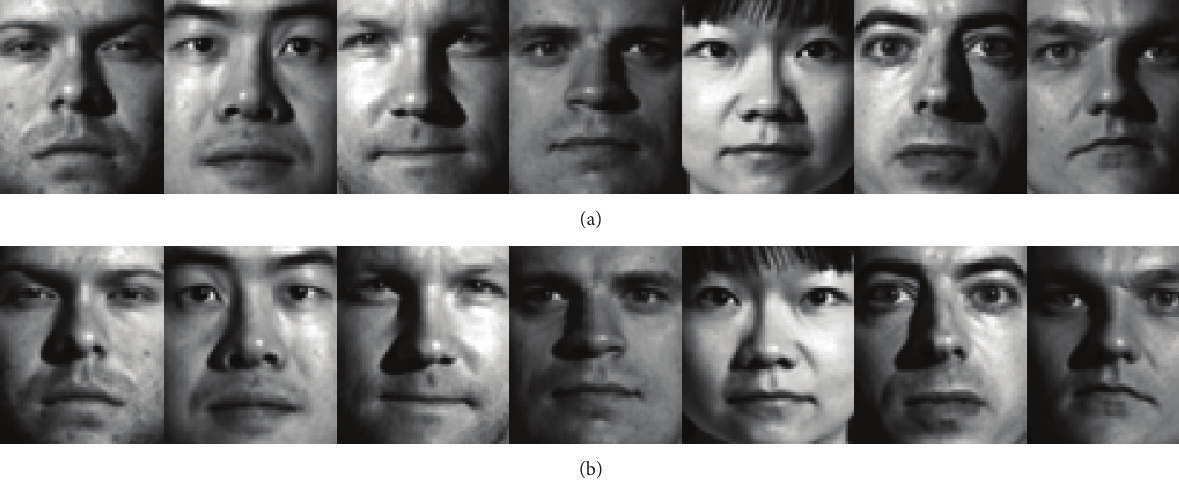
Figure 2: Some original training samples from the Yale B database and the mirror faces generated from the original training samples. The first row shows the original training samples. The second row shows the mirror faces generated from the original training